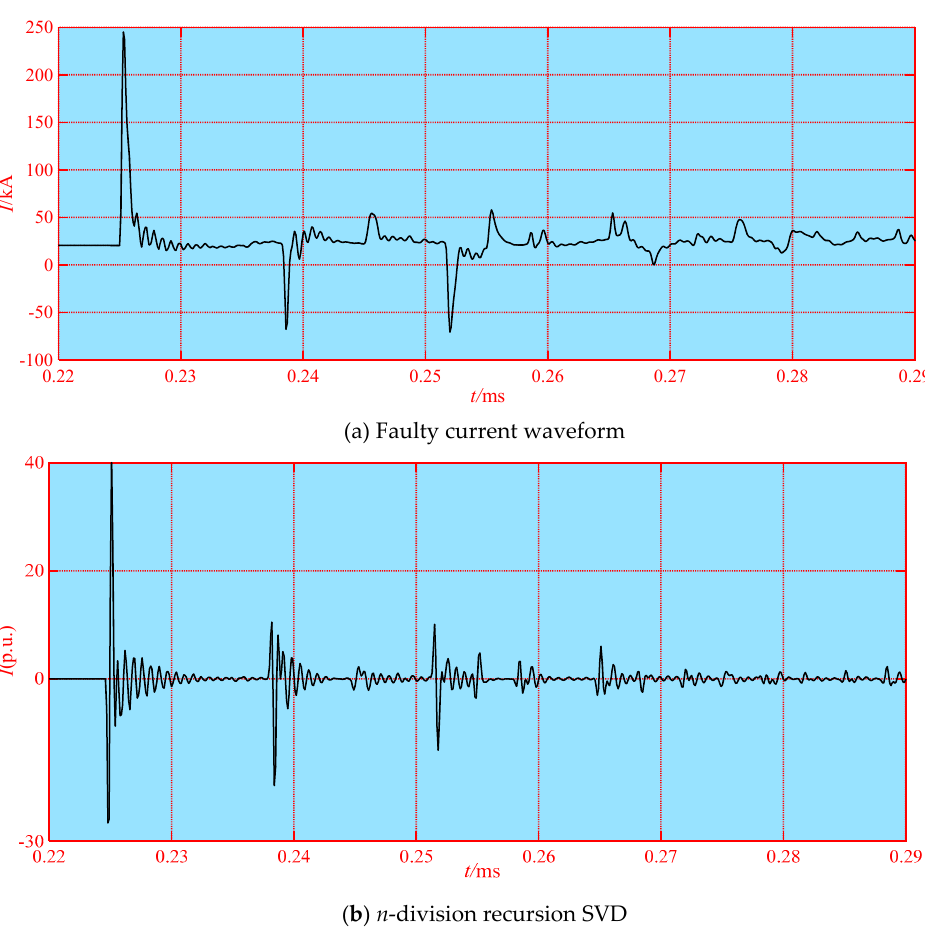
Figure 12. Singular value calibration of n -division recursion SVD for section l 3 fault travelling wave. The results of the combination of the full-line matching algorithm and SVD shown in Figure 13. The result of the calculation is that the fault occurred within l 3 of the fault section, and the fault distance is x F = 75.1 km.